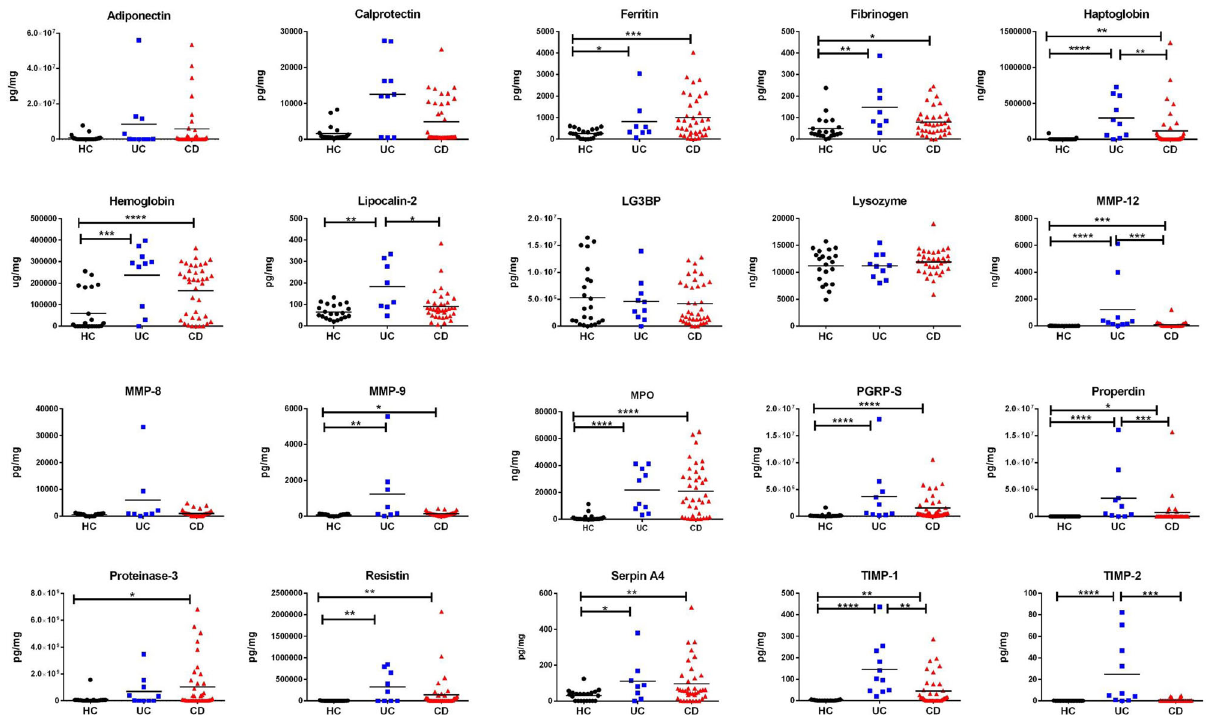
Fig. 3 Cross-sectional ELISA validation of elevated stool proteins in pediatric IBD stool. Shown are the ELISA validation results of 20 stool proteins in a cross-sectional cohort of 73 pediatric subjects (24 healthy controls, 10 UC, and 39 CD). The concentration of each protein was assayed in the 73 subjects ’ stool and then normalized to mg of a stool sample. The horizontal line represents the mean of each subject group. * p < 0.05, ** p < 0.01, *** p < 0.001, and **** p < 0.0001 as determined using two-sided Mann – Whitney